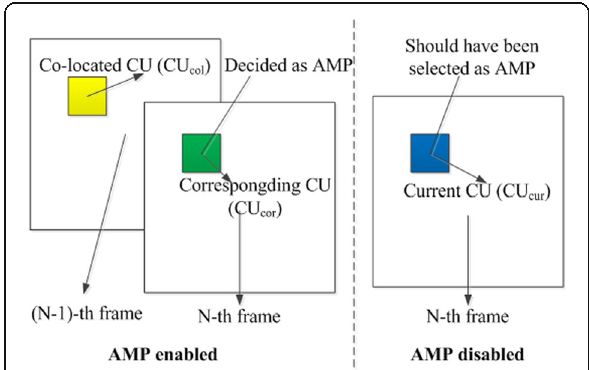
Fig. 4 Corresponding positions of each type CU with AMP enabled and